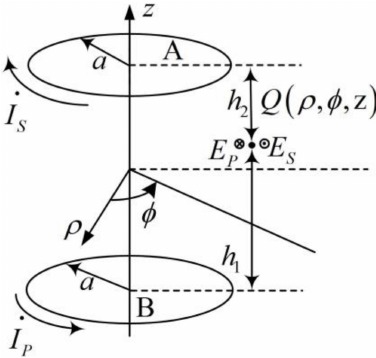
Figure 5. Illustration of the electric field at a sampling point of the double-coil IPT